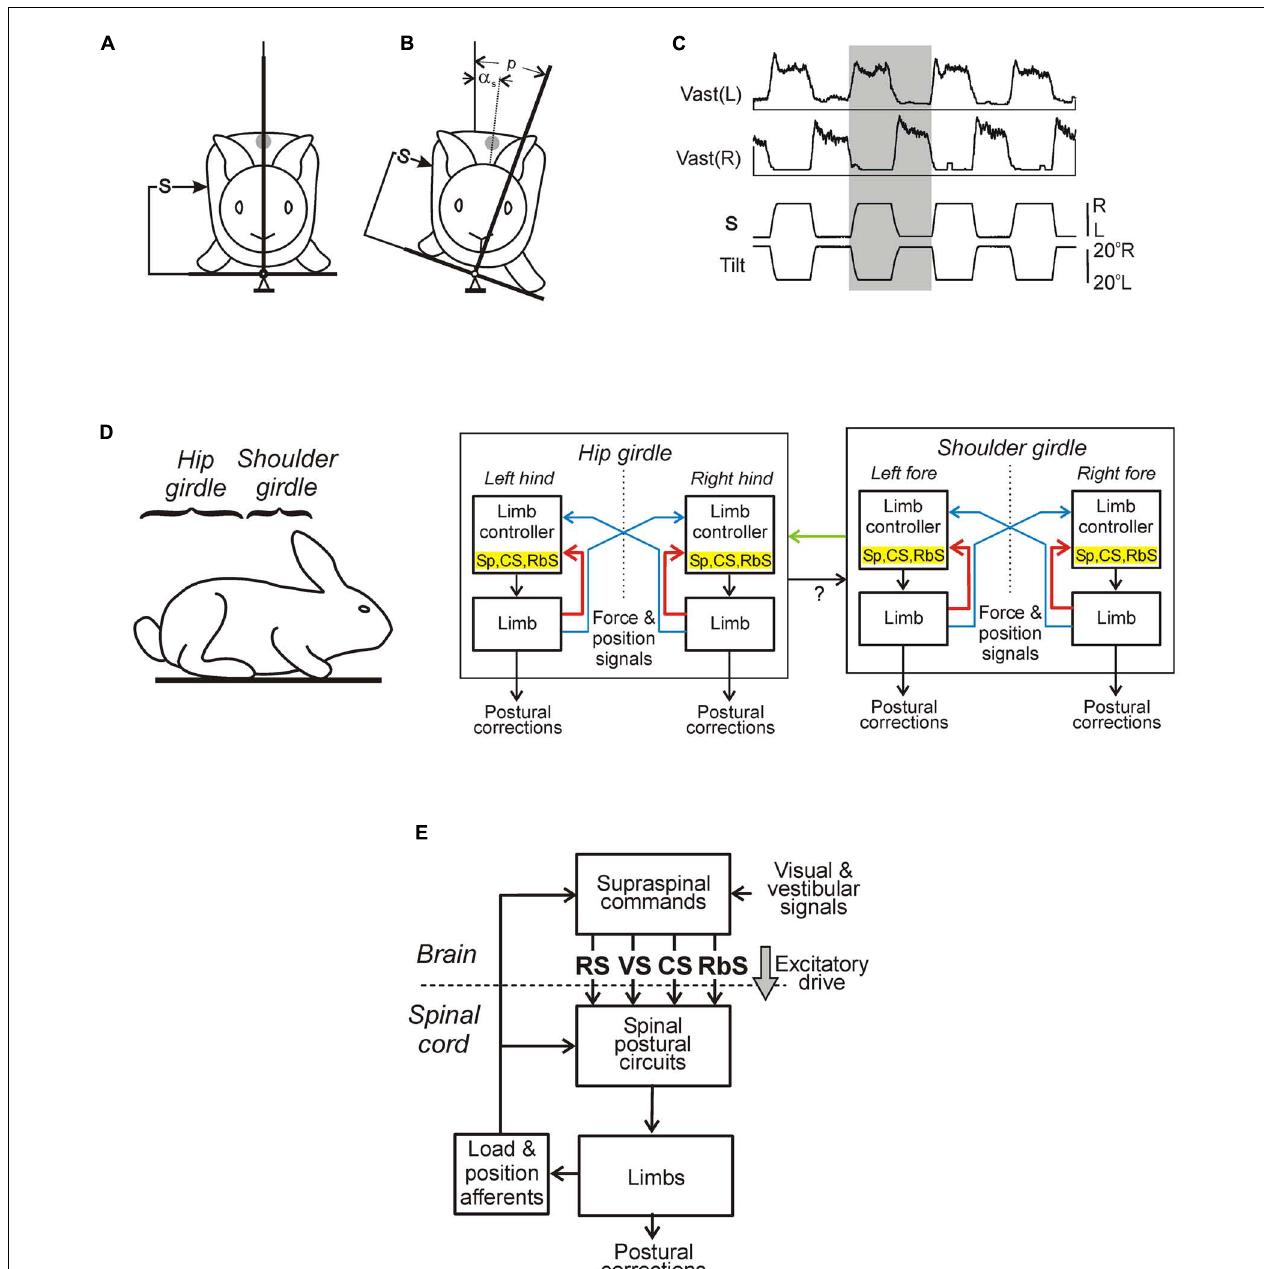
FIGURE 6 | Maintenance of body orientation in the transverse plane in the standing rabbit. (A,B) Experimental design for testing postural responses to lateral tilts of the support surface.The platform tilt (p), the trunk tilt after execution of postural correction ( α s ), as well as the position of mechanical sensor (S) measuring the lateral displacement of the trunk in relation to the platform (the trunk corrective movement) are indicated. (C) Motor and EMG responses to trapezoidal tilts.Vast(L) andVast(R) are left and right m. vastus lateralis, respectively. (D) Functional model of the postural system stabilizing the trunk orientation in the transverse plane. Lateral stability of the anterior and posterior parts of the body (shoulder and hip girdles) is maintained by two relatively independent sub-systems. Each sub-system contains two controllers (for the right and left limbs) generating a part of corrective limb movement in response to sensory input from the same